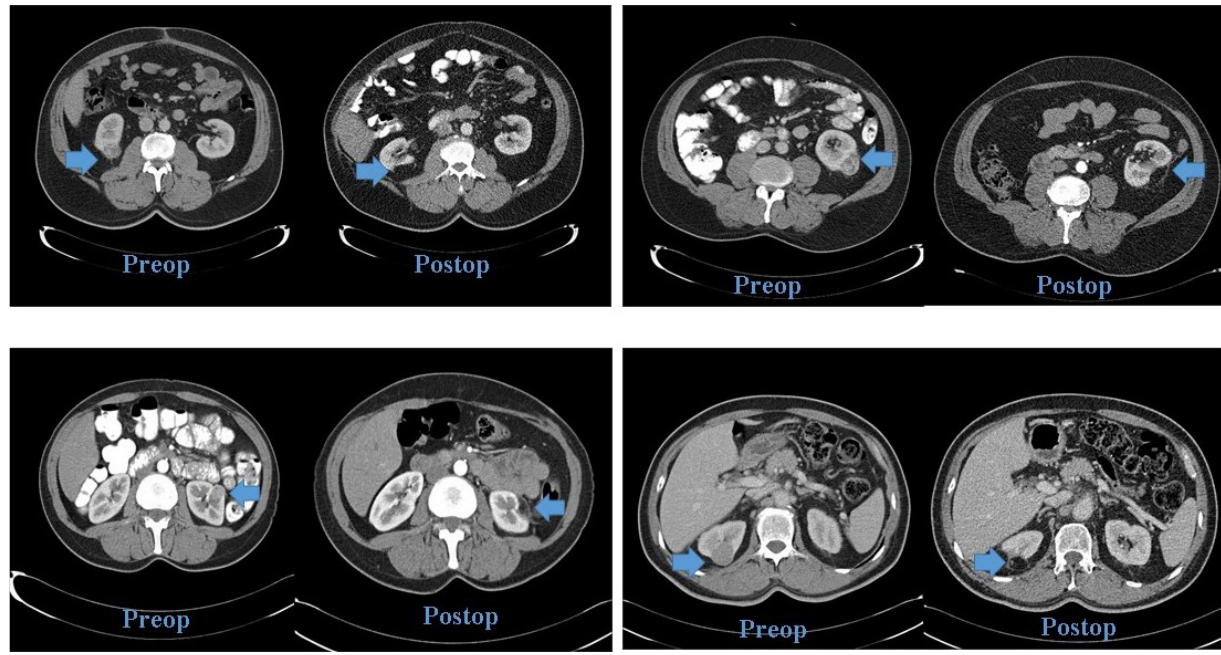
Figure 2: Image of postsurgical fatty tumor through contrast abdomen computed